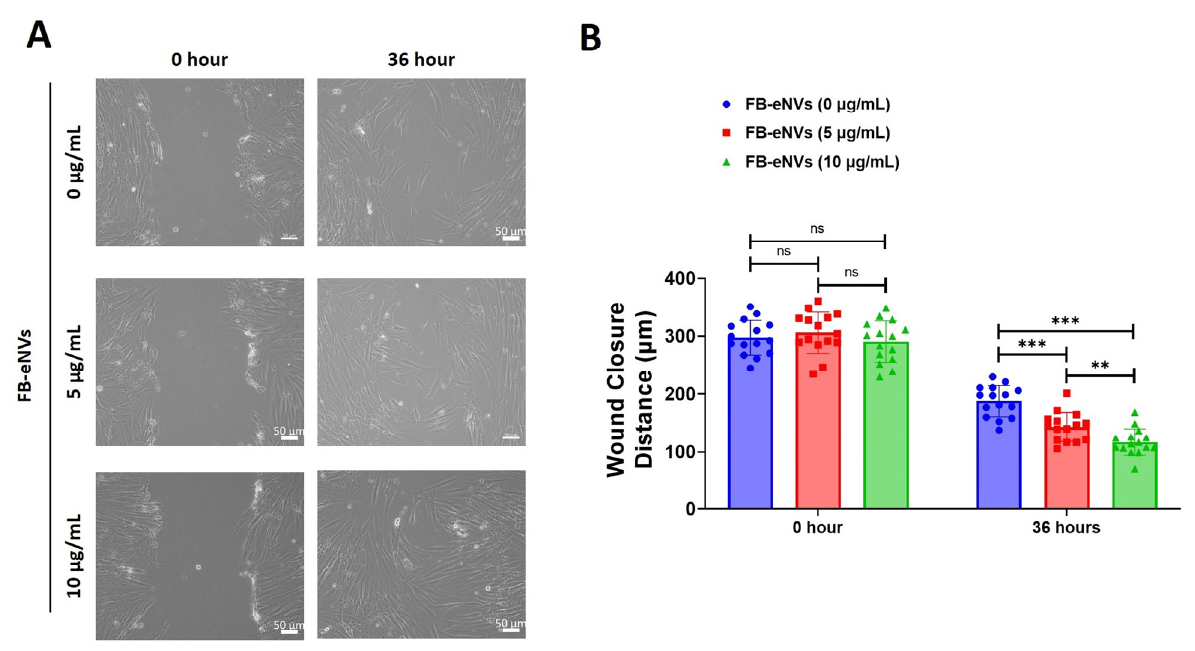
Figure 4. FB-eNVs promoted the migration of DP cells. ( A ) Phase-contrast microscopy images of migrated cells at 0 and 36 h after FB-eNV (5 and 10 µ g/mL) treatment. Scale bar: 50 µ m. ( B ) Percentage of wound closure ( n = 16) at 0 and 36 h after FB-eNV (5 and 10 µ g/mL) treatment. The values are mean ± sd of a minimum of three replicates of an experiment. Student’s t -test was used. ** p < 0.01; and *** p < 0.001. ns: not significant.